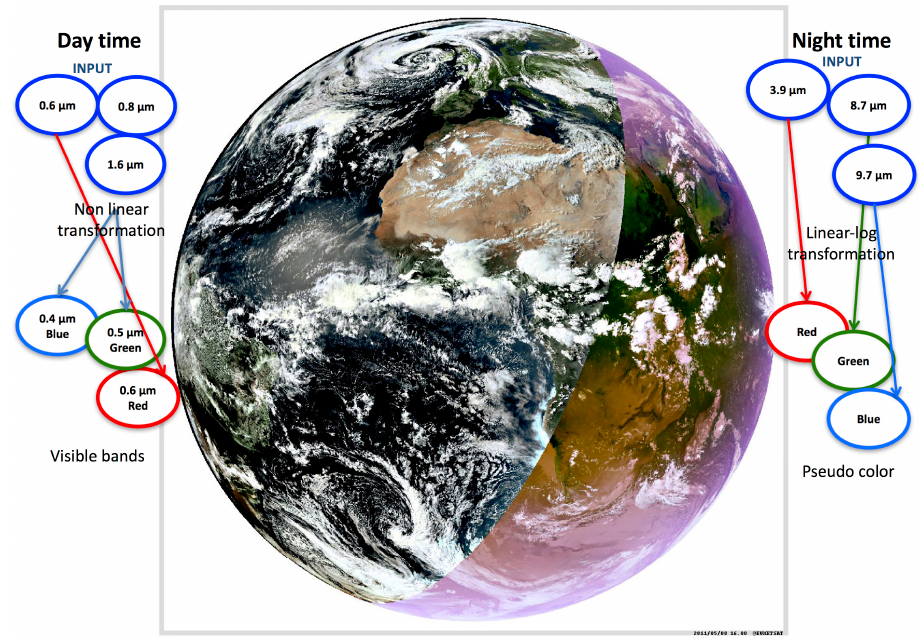
Figure 3. Day/night color rendering illustration. The RGB color composites are built from the input data (upper blue circles) by non-linear ANN (day-time) and linear-log transformation (nighttime).